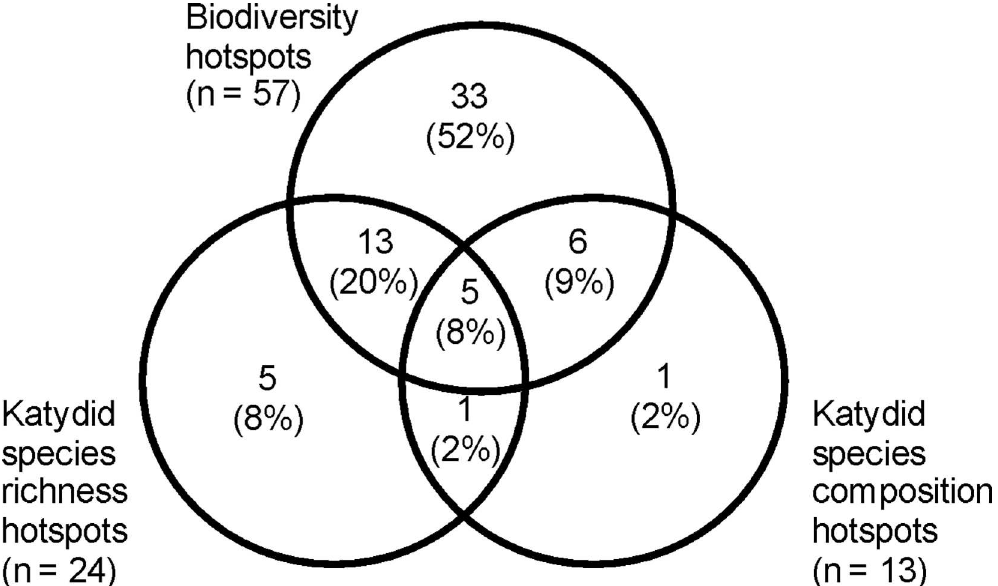
Fig 4. Types of hotspotdistribution. Venn diagram illustratingnumberand percentageof grid cells selected as biodiversity hotspots, katydid species richness hotspotsor katydid species composition hotspotsand the degree of overlap between